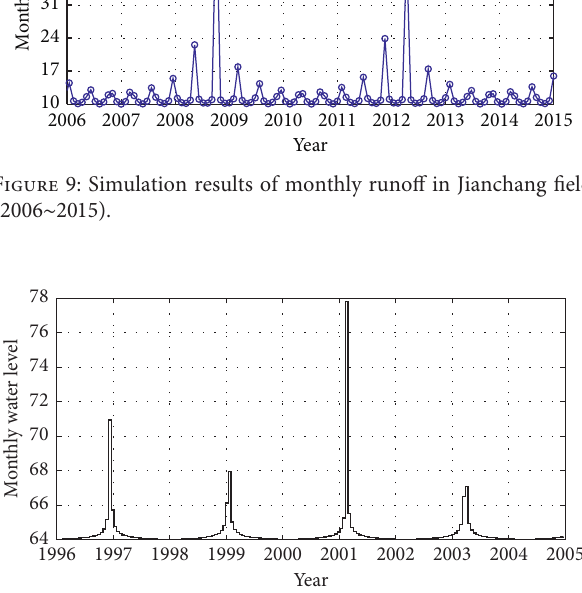
Figure 10: Simulation results of monthly water level in the Biliu River Reservoir (1996 ∼ 2005).